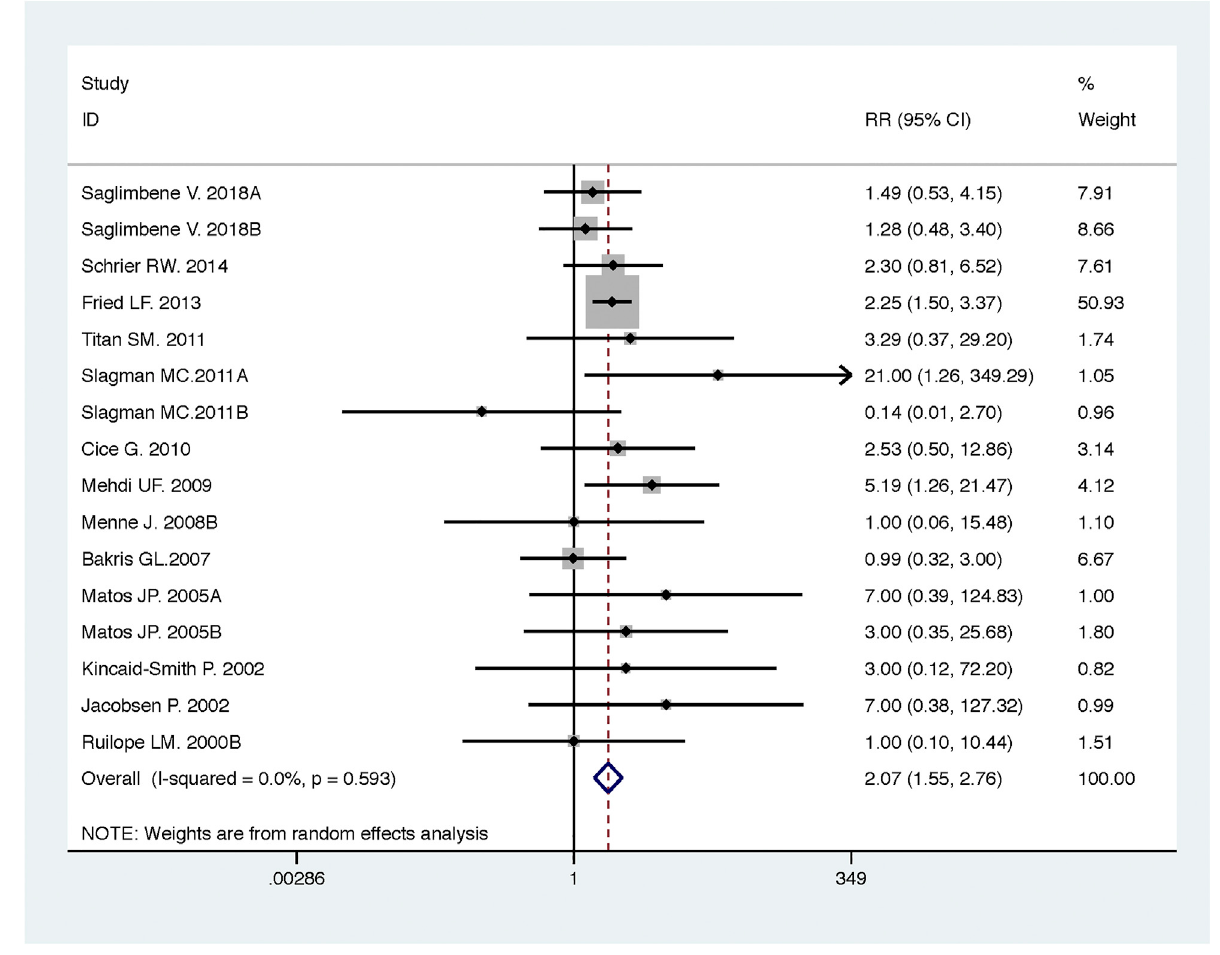
Frontiers in Pharmacology |